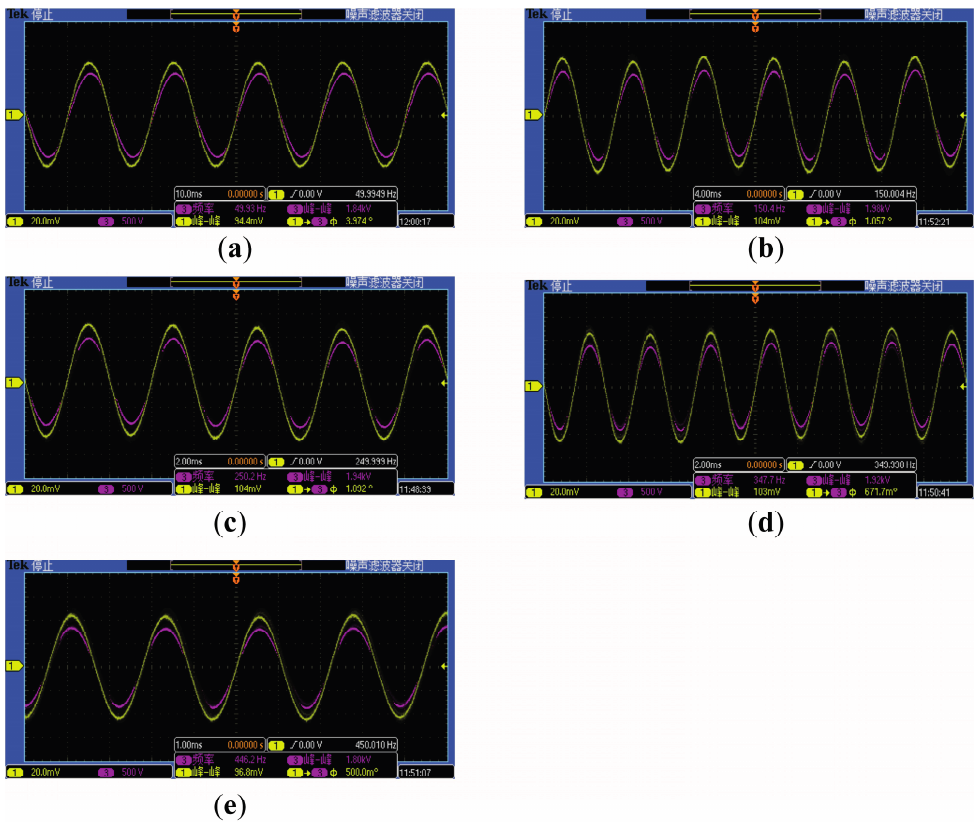
Figure 11. Waveform comparison chart at frequency ( a ) 50 Hz; ( b ) 150 Hz; ( c ) 250 Hz; ( d ) 350 Hz; ( e ) 450